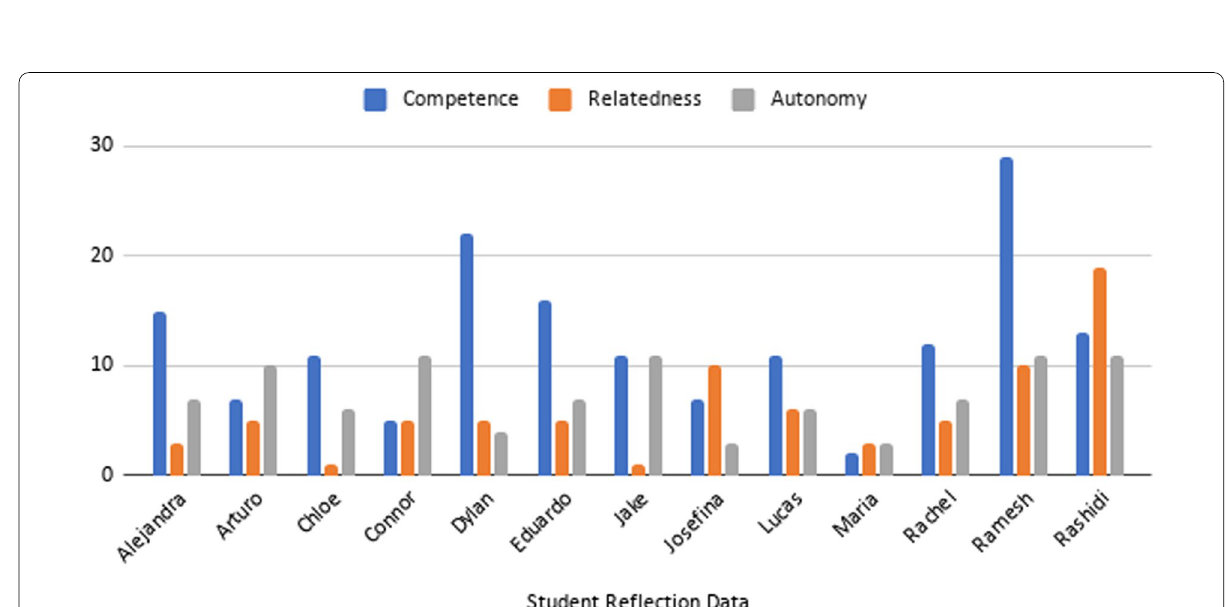
Fig. 1 Frequency counts of SDT constructs before the transition to remote